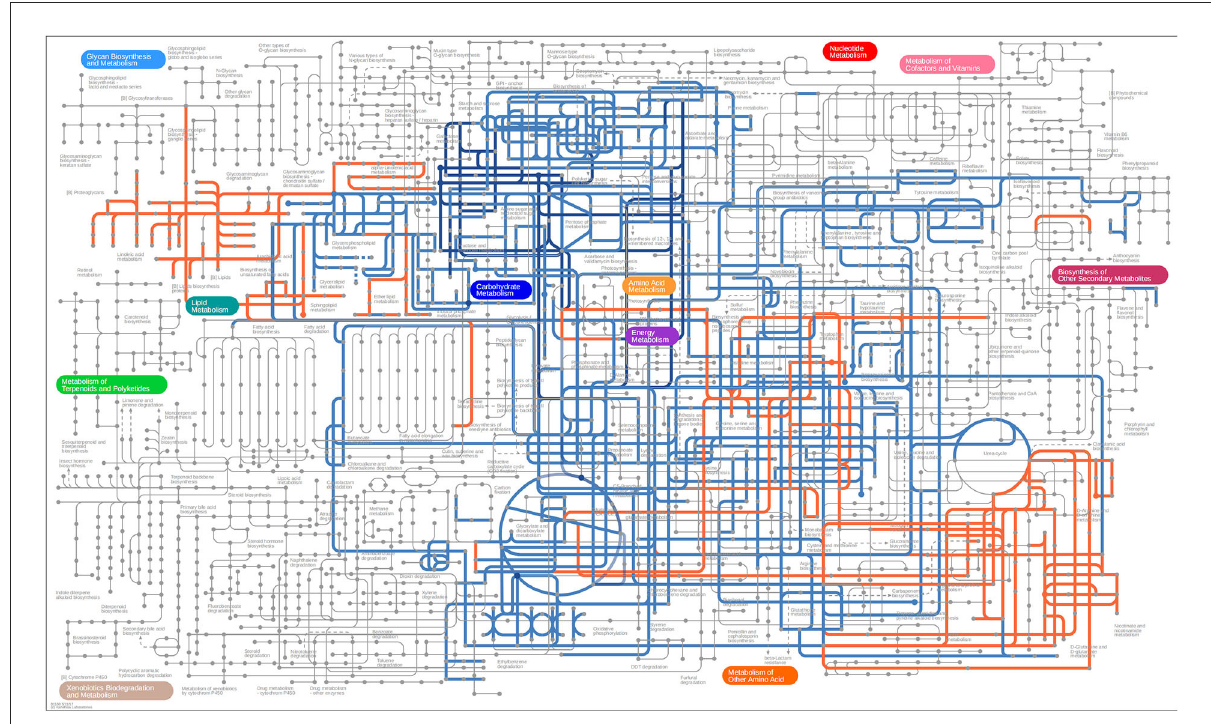
FIGURE6 KEGG network annotated using iPath 3. Blue and orange represent the pathway analysis of differential metabolites in seminal plasma and sperm, respectively.